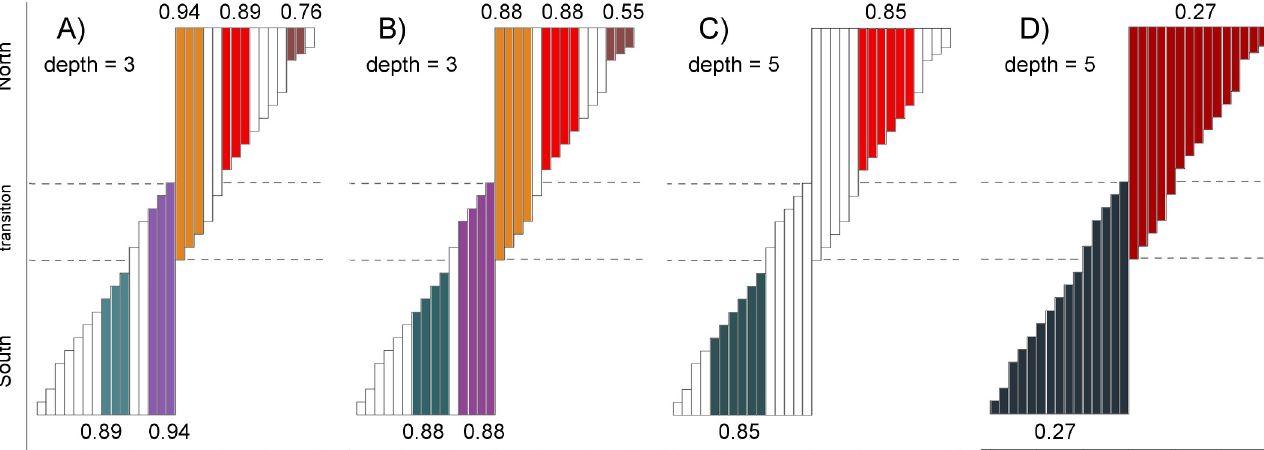
Fig 3. Partial chorotypes (closed lists) detected in a simulated gradient of ranges. Like colors indicate species ranges (bars) grouped into partial chorotypes recovered at particular congruence thresholds (minimum C T values are shown at the base and top of each closed group). White bars indicate “biogeographically uninformative” species that did not give rise to and were not included in any closed list, at each corresponding maximum depth setting. Four examples are shown (see S1 Table for full details). A) Small but highly congruent partial chorotypes (closed groups) were located next to zones of range discontinuity and favored larger ranges, with smaller proportional area differences. The extended discontinuity only at the northern extreme allowed the recognition of one pattern composed of small-range species. B) At lower congruence thresholds (e.g., from 0.94 to 0.88, or 0.89 to 0.88, or 0.76 to 0.55; compare Fig 3A and 3B), partial chorotypes included adjacent species with smaller ranges. C) Increasing depth (allowing more levels of indirect congruences) increased the size of partial chorotypes at relatively high congruence thresholds. D) At lower congruence thresholds, the entire northern and southern groups were recovered as a whole. Allowing for extensive indirect range comparisons (maximum depth of 10, not shown), most reference species led to convergence on a single chorotype. Note that all recovered partial chorotypes can be nested in others and there was no non-nested overlap nor recovery of the transition zone as an independent